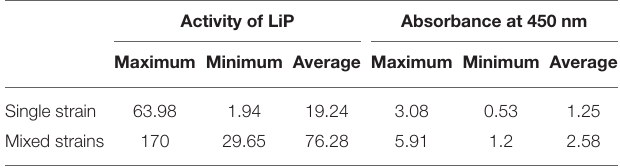
TABLE 1 | Comparison of liquefaction of lignite by single strains and mixed strains. Activity of LiP Absorbance at 450 nm Maximum Minimum Average Maximum Minimum Average